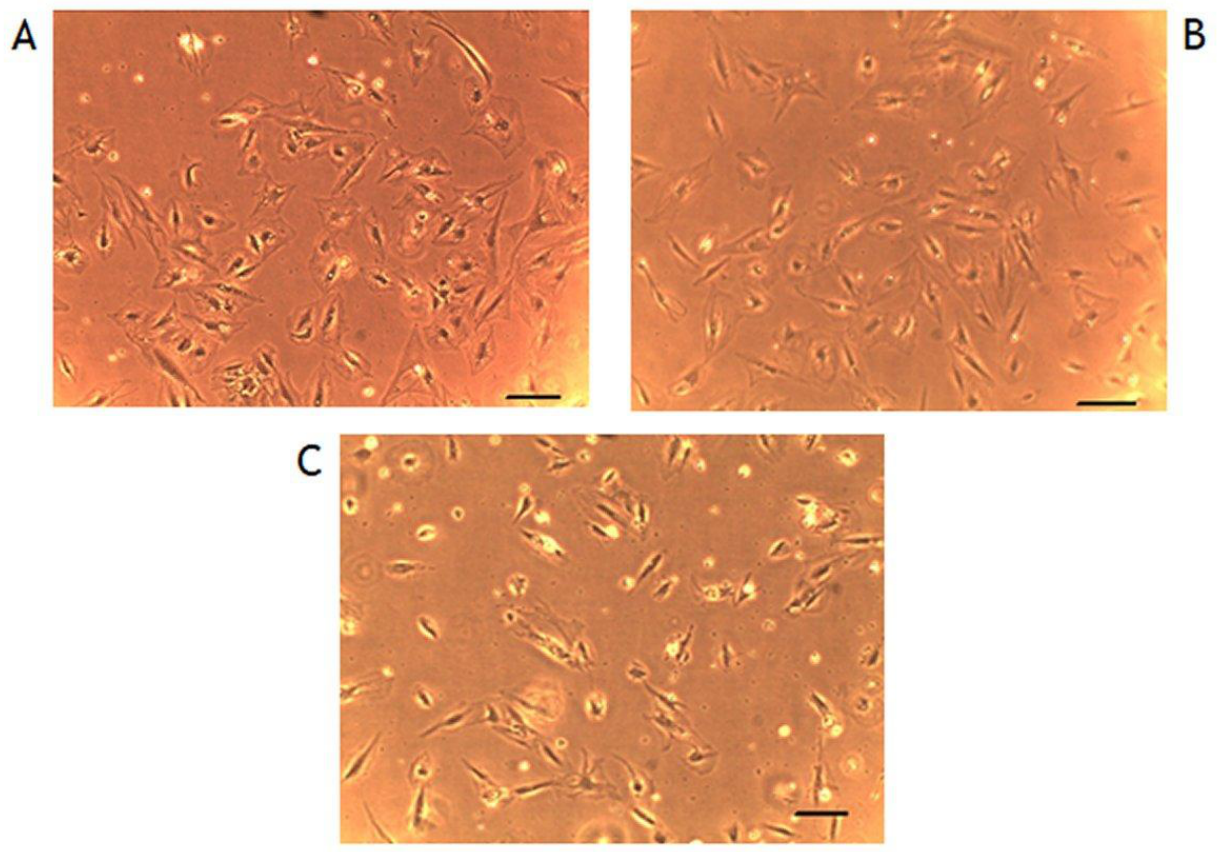
Figure 4 : Representative examples of cultured cells’ micrographs under different experimental conditions (scale 20 µm). A: Controls not exposed to external electromagnetic field (EMF). B: Cells exposed to 10 Hz EMF. C: Cells exposed to the pulsed electromagnetic field (PEMF). No gross difference in cell numbers is apparent in the experiment